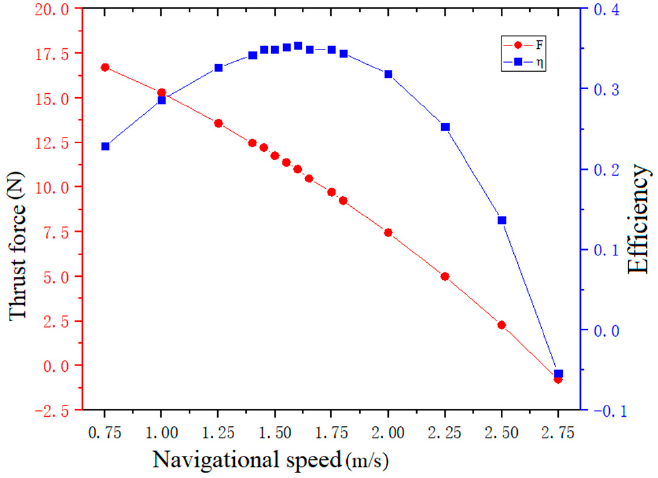
Figure 7. Performance curves of ducted propeller at impeller rotational speed at 2000 r/min. In order to verify the accuracy of the numerical calculation results, the performance results of the ducted propeller are compared at navigational speed of 0.37 m/s under different impeller rotational speeds, as shown in Figure 8. In post numerical simulation, the thrust and power of the ducted propeller are obtained by the following